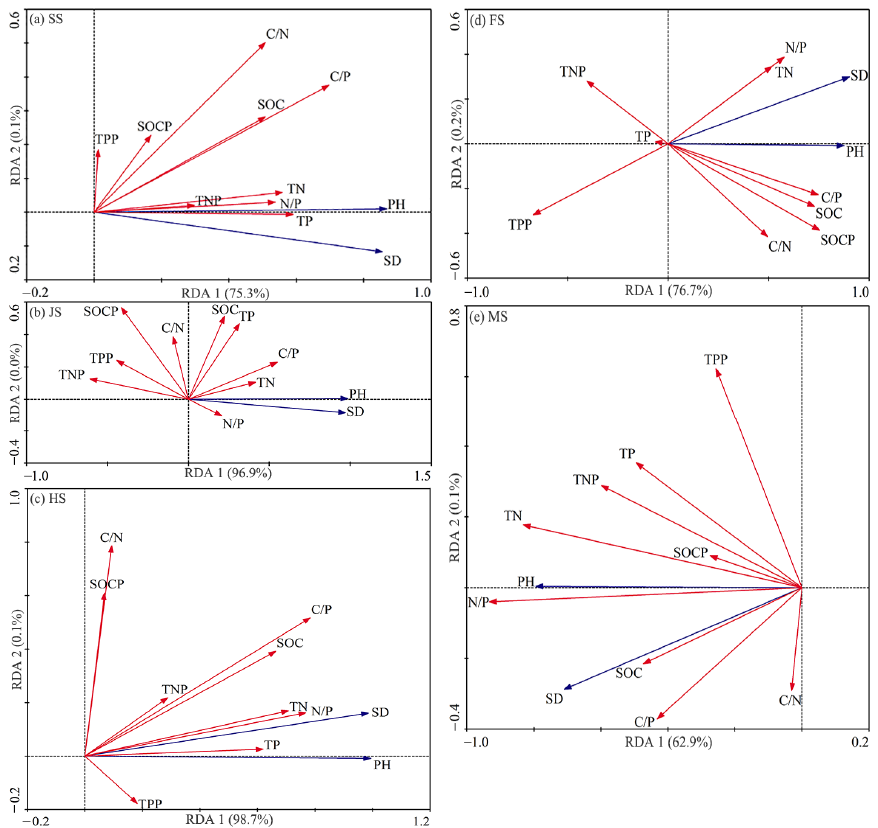
Figure 6. Coordination biplots of redundancy analysis (RDA) displaying the relationship